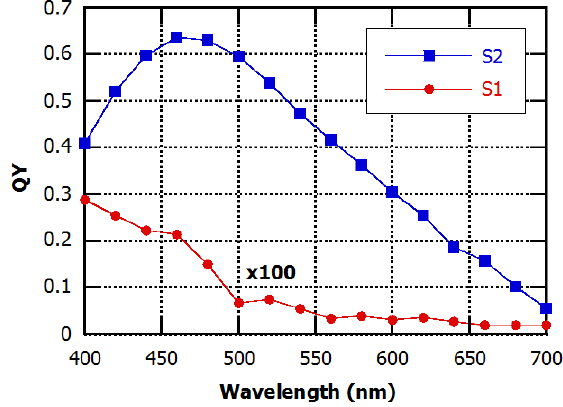
Figure 7. Quantum efficiency characteristics of the two diodes of the device at V bias = 0 V and at room temperature.